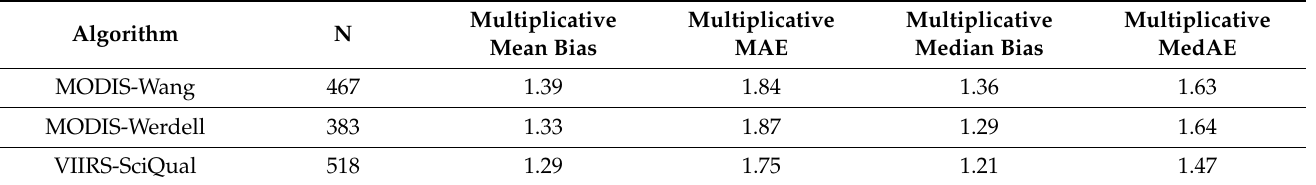
Table 2. Multiplicative mean and bias and Absolute Error (AE) for the CoastWatch suite of products, which are plotted by station in Figures 9 and